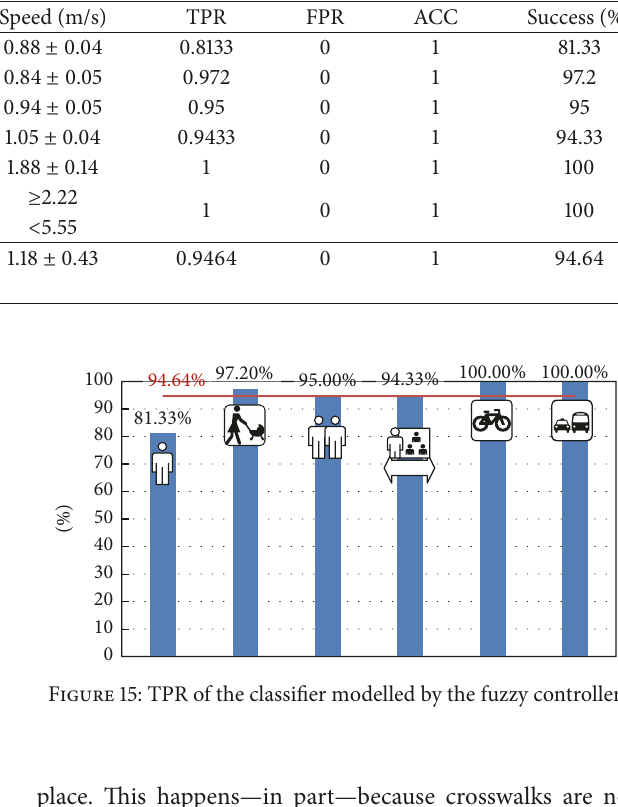
place. This happens—in part—because crosswalks are not 100% visible for drivers due to different reasons: (i) poor road maintenance, (ii) occlusion of vertical signs, and/or (iii) adverse weather conditions, among